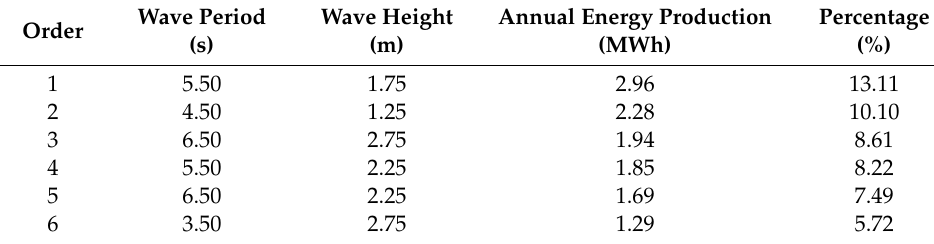
Table 3. A list of most-contributed wave climates to the overall energy